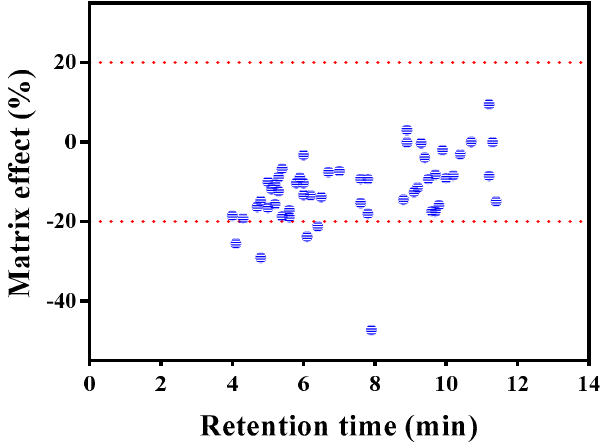
Figure 4. Matrix e ff ects of 55 pesticides obtained by Clean-up V (contained ENVI-Carb) Figure 4. Matrix effects of 55 pesticides obtained by Clean-up V (contained ENVI-Carb) procedure.